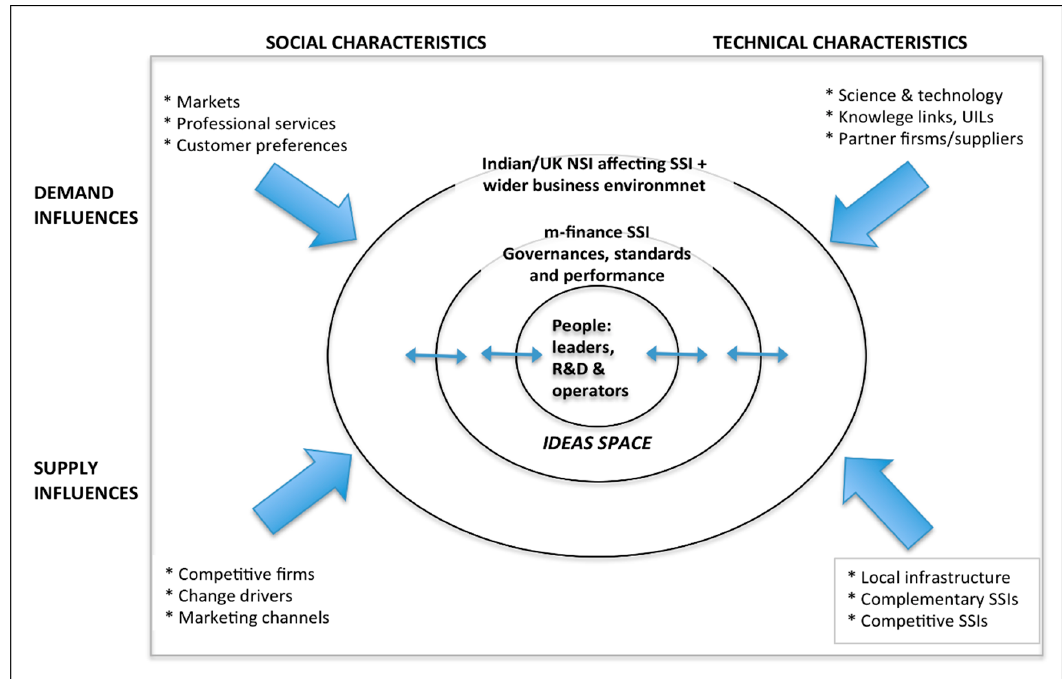
Figure 2. Institutions and components with their inter-relationships constituting the m-payments SSI.